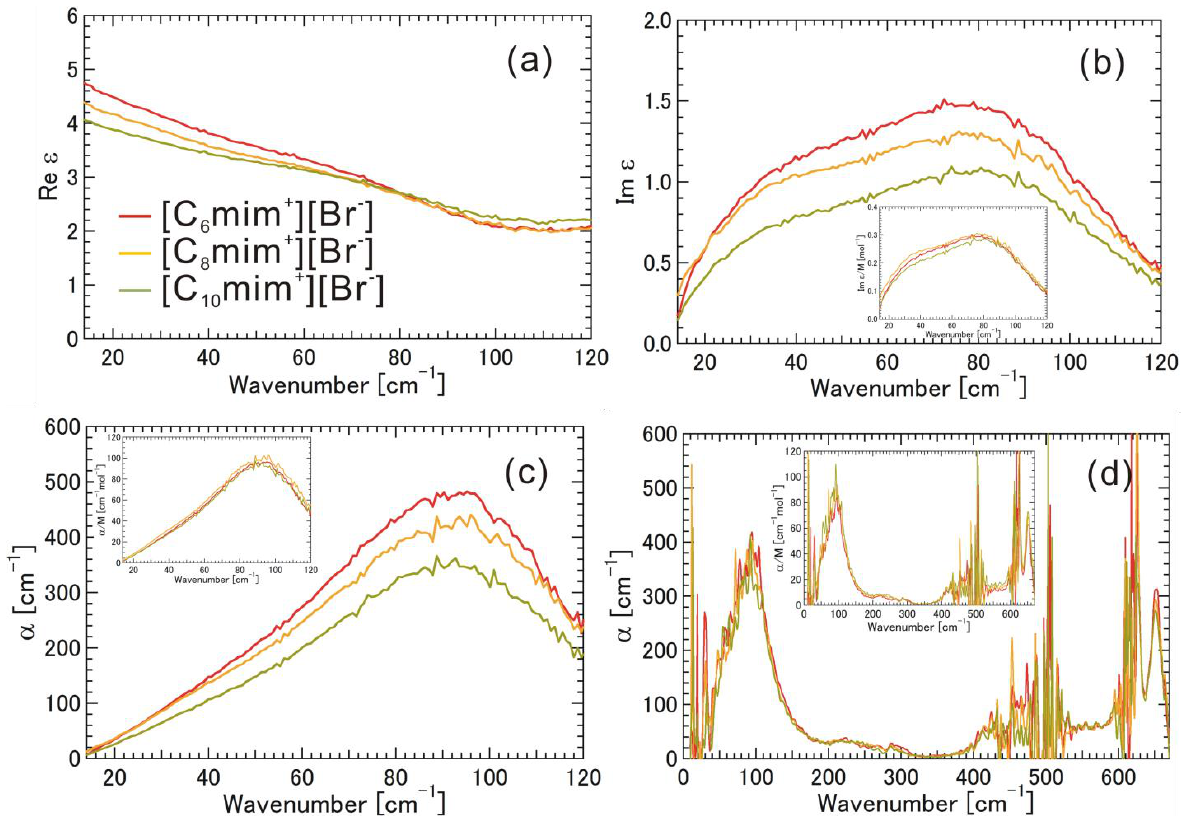
Figure 3. ( a ) Real part of the complex dielectric spectra (Re ε); ( b ) Imaginary part of the complex dielectric spectra (Im ε); ( c ) Absorption coefficients (α) obtained by THz-TDS, and ( d ) Absorption coefficients (α) obtained by FIR, for the ionic liquids [C 6 mim + ][Br − ], [C 8 mim + ][Br − ], and [C 10 mim + ][Br − ]. The imaginary part of the complex dielectric spectra (Im ε/M) and absorption coefficient (α/M) normalized by molar concentration are also shown in the insets.